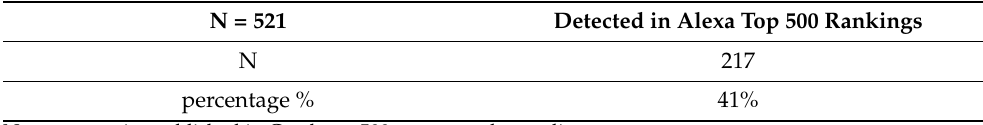
Table 2. Cases detected in Alexa top 500 rankings in Greece.